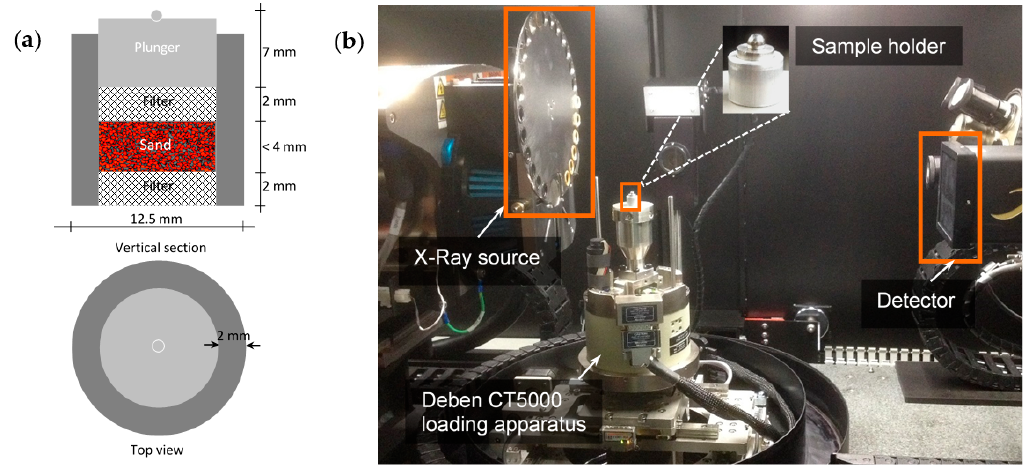
Figure 2. ( a ) Sample holder setup; ( b ) Test setup within X-ray computed tomography (X-ray CT) machine.